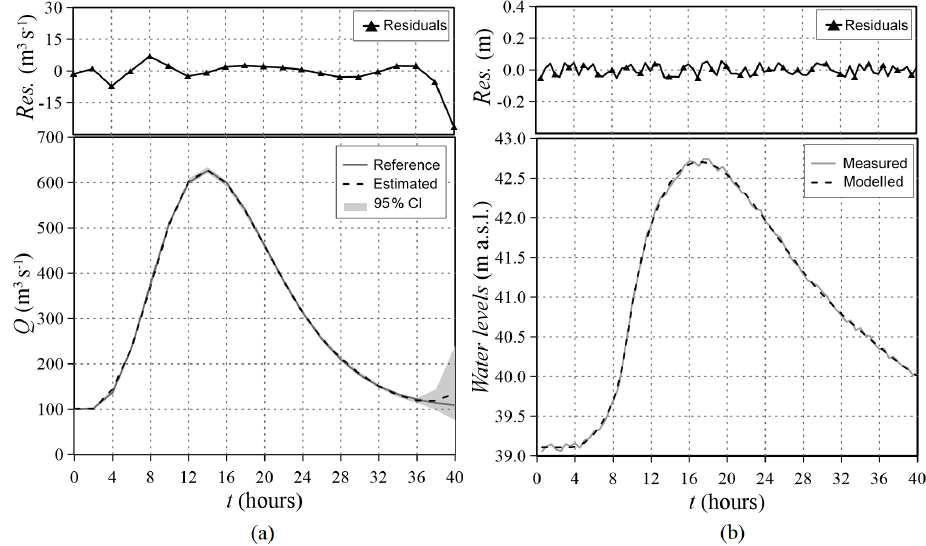
Figure 10. Parma River: reference and estimated (with a 95% credibility interval) inflow hydrographs (a) and observed (corrupted) and modelled water levels (b) . The residuals between reference and estimated values are also reported.